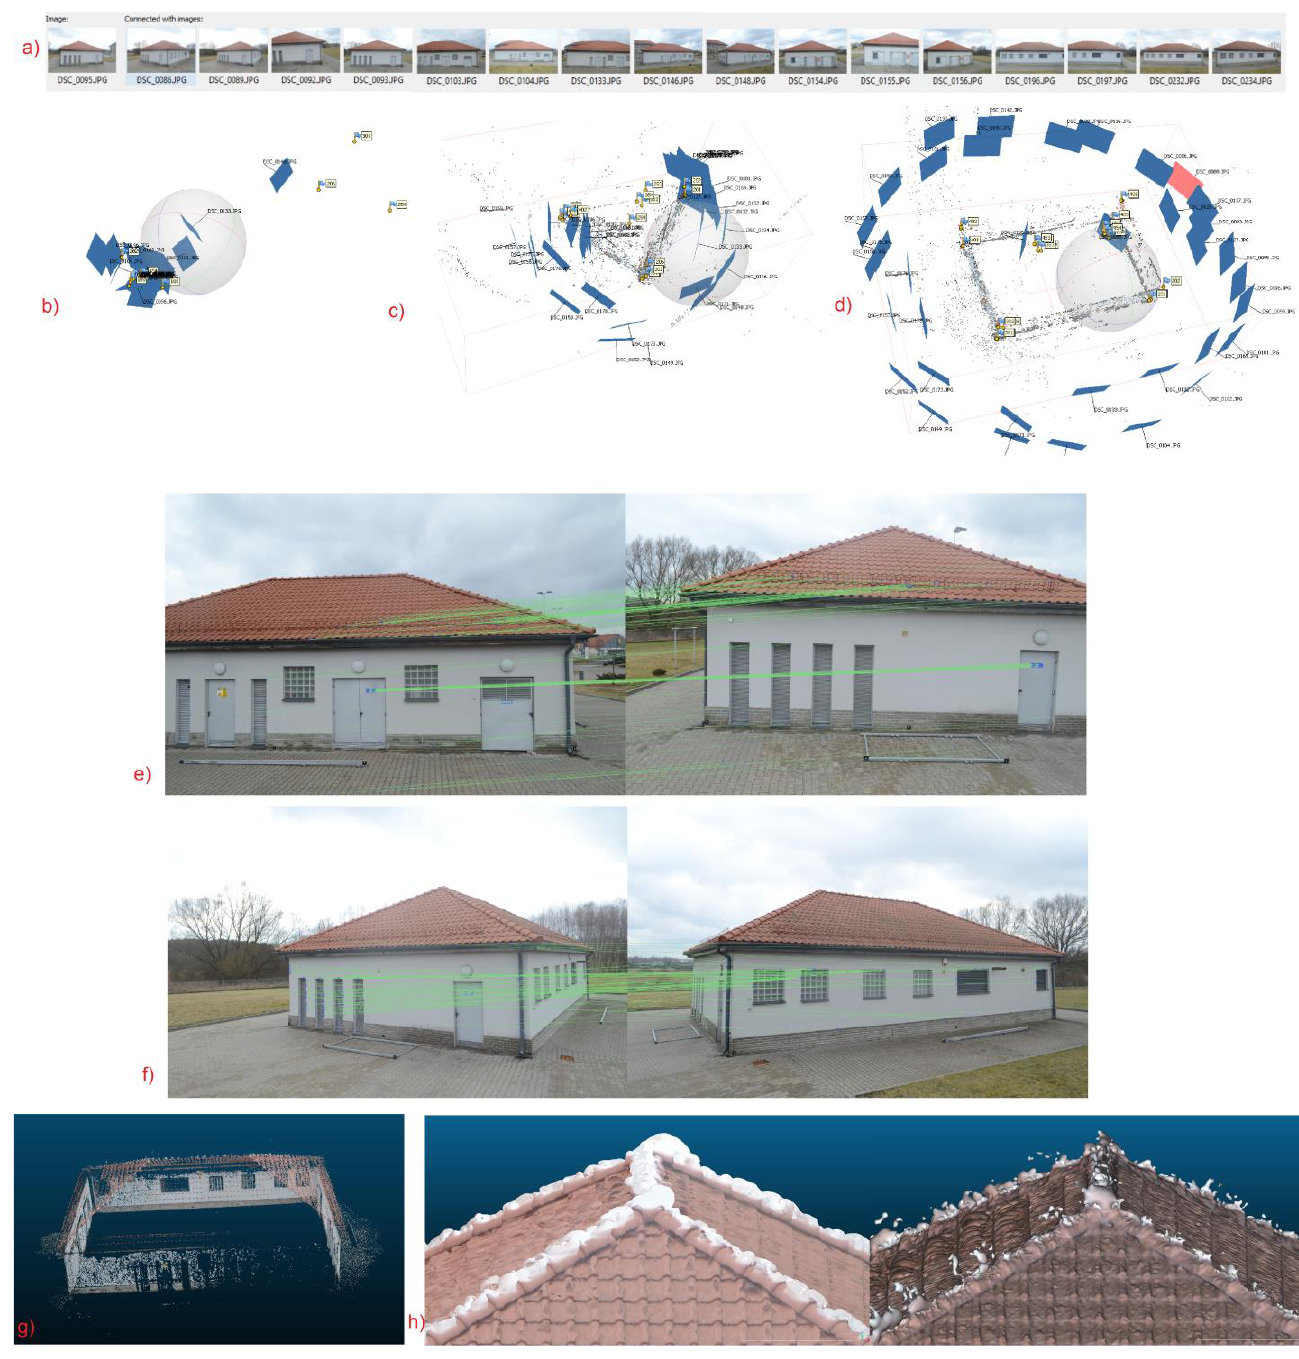
Figure 15. Software problems in processing the CRBeDaSet: ( a ) faulty matching of tie points; ( b – d ) the examples of the problems with optimal selection of tie points and weight assignment; matching problems related to ( e ) repeated regular shapes and color of roofing tiles and ( f ) localization of windows and vent holes near homogenous texture of wall; ( g ) shortages in point clouds; ( h ) difficulty with correct automatic filtering of dense point clouds during the mesh generation.